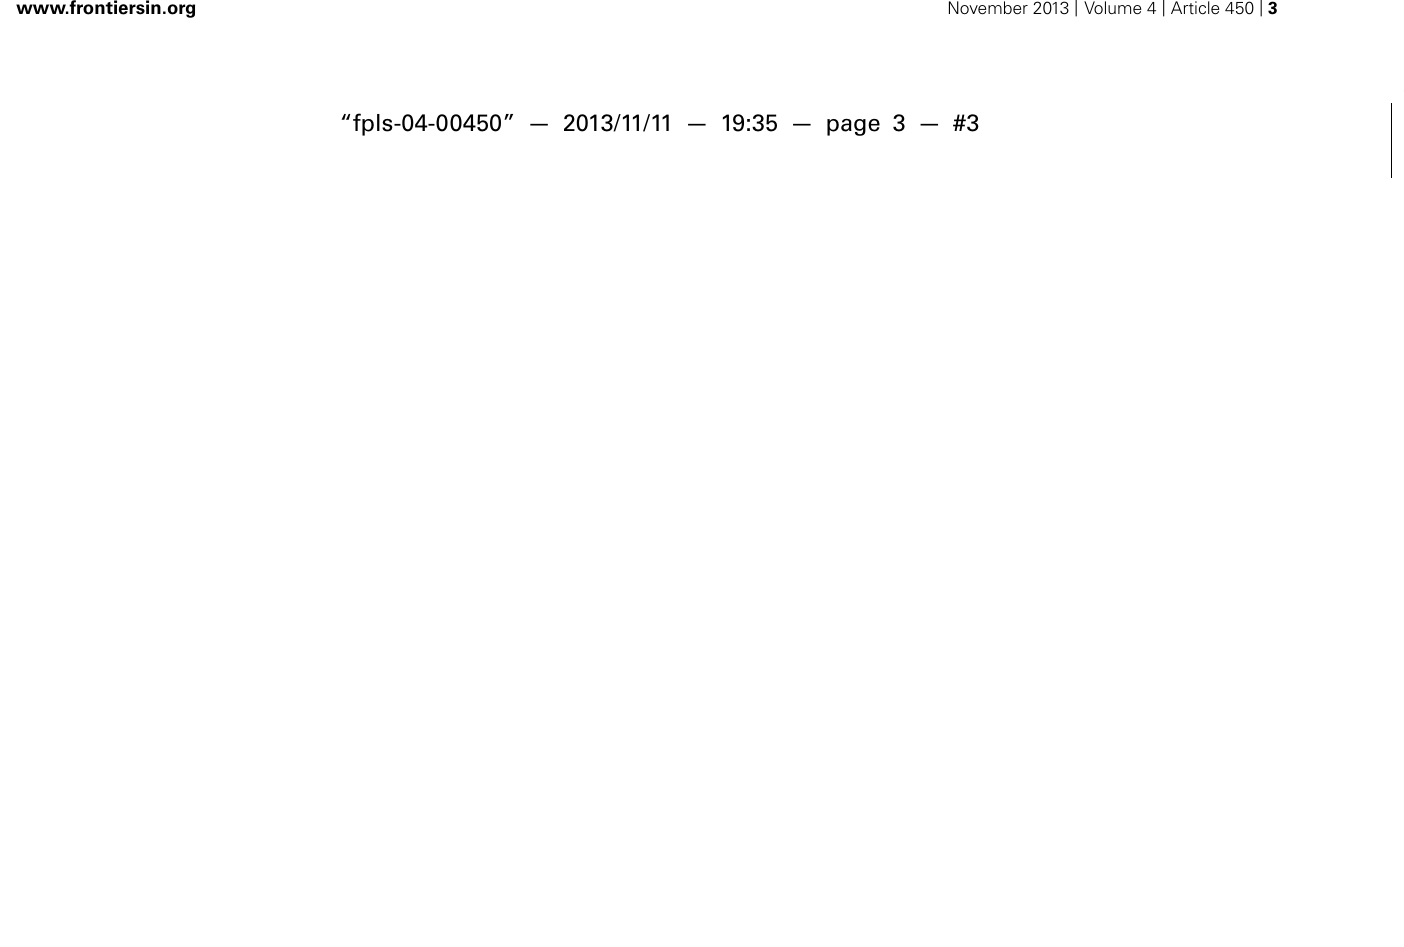
representation of the crystal structure of a single OsGAPDH subunit.The cofactor-binding domain is yellow, the catalytic domain blue and the S-loop gray.The NAD + , the sulfate ions occupying the Ps and Pi sites and the catalytic residues (Cys-154 and His-181) are represented as